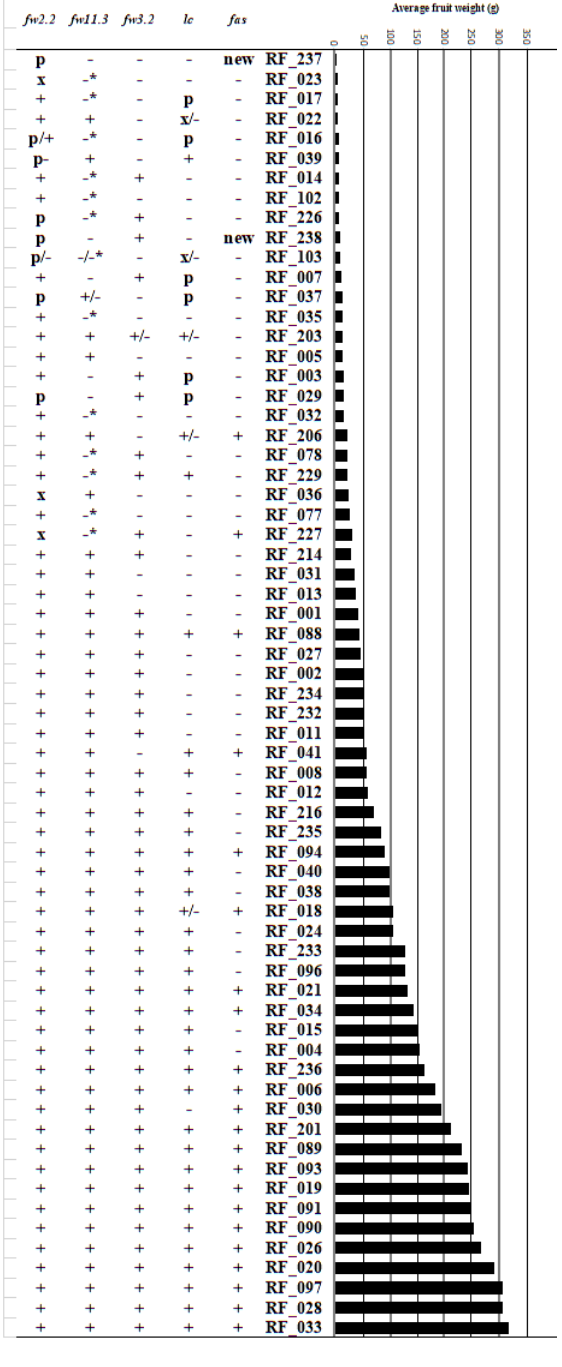
Figure 9. The relationship between size locus haplotype and fruit weight. The different allelic forms are described in the caption of Table 2.